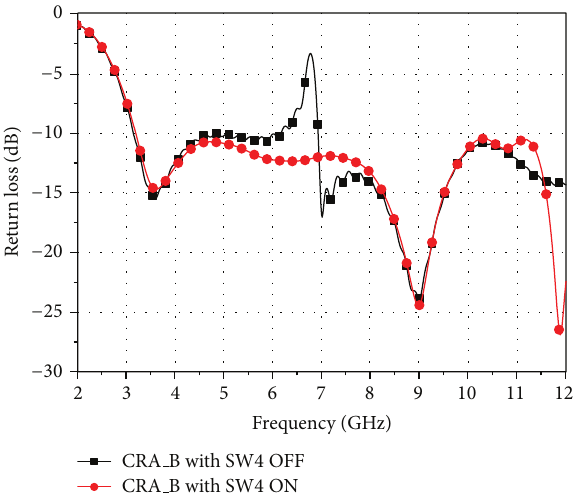
Figure 9: Reconfigurable characteristics of CRA B.